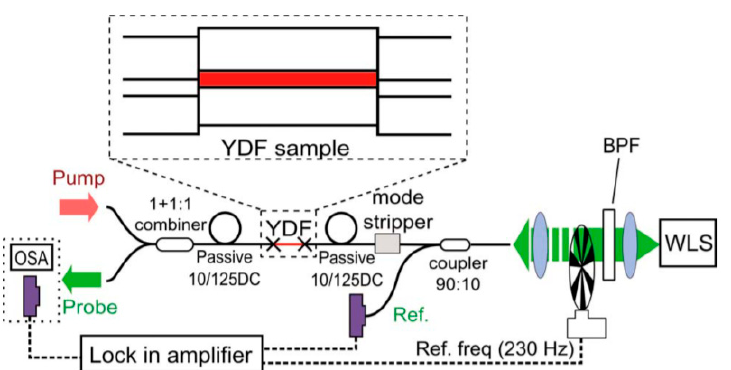
Figure 9. Experimental setup for RIC measurement. YDF, Yb-doped fiber; BPF, bandpass filter; WLS, white light source; OSA, optical spectrum analyzer. Adapted with permission from [28] © The Optical Society.